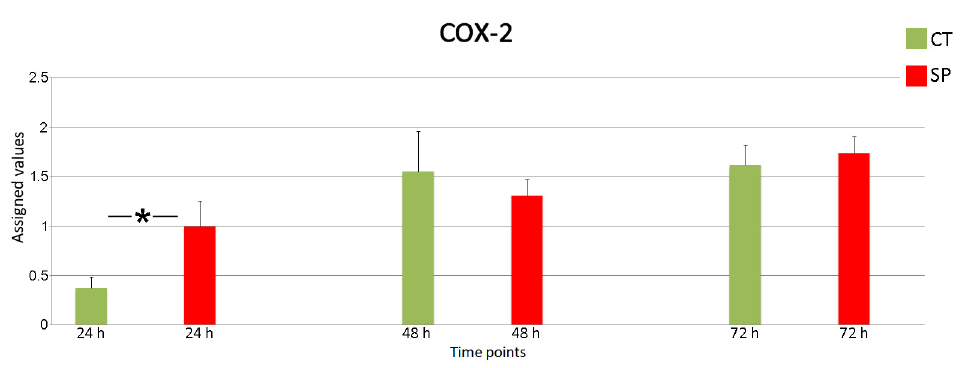
Figure 14. Mean ± standard error values of anti-COX-2 labeling values. Asterisks indicate significant